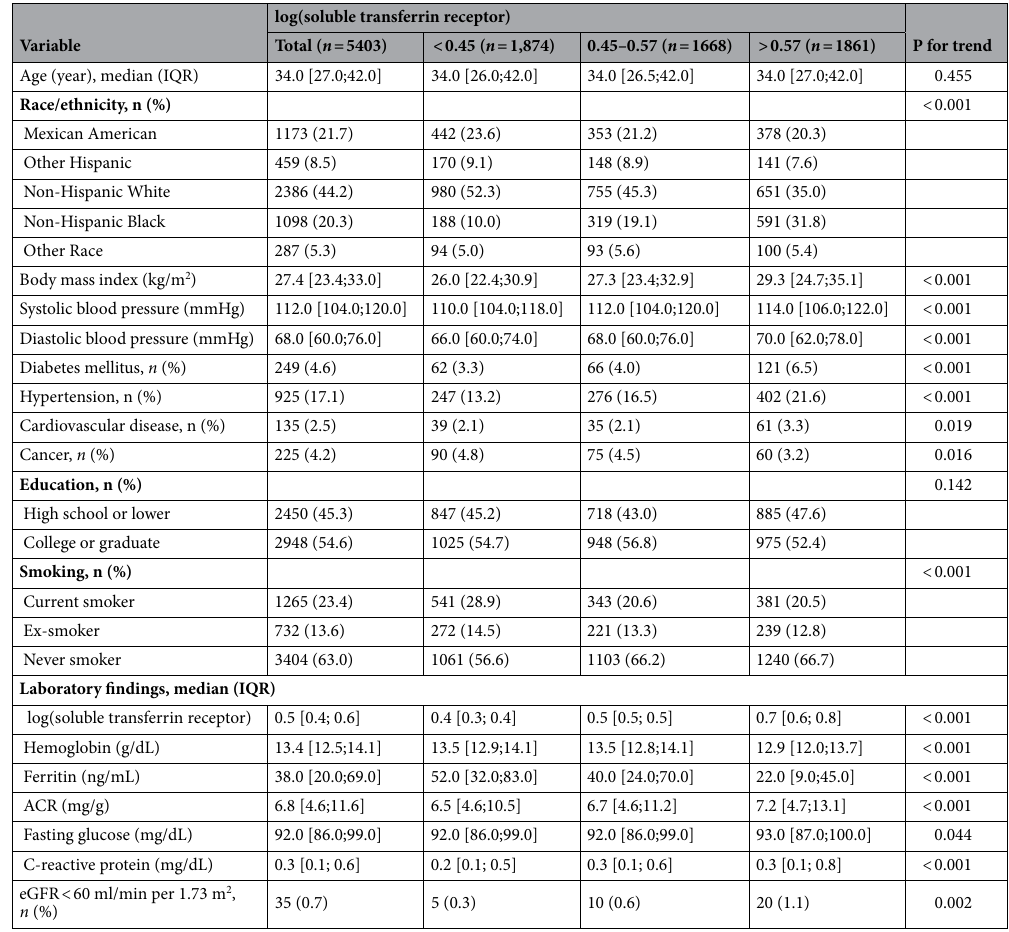
Table 1. Baseline participant characteristics. ACR random urine albumin-to-creatinine ratio, eGFR estimated glomerular filtration rate.